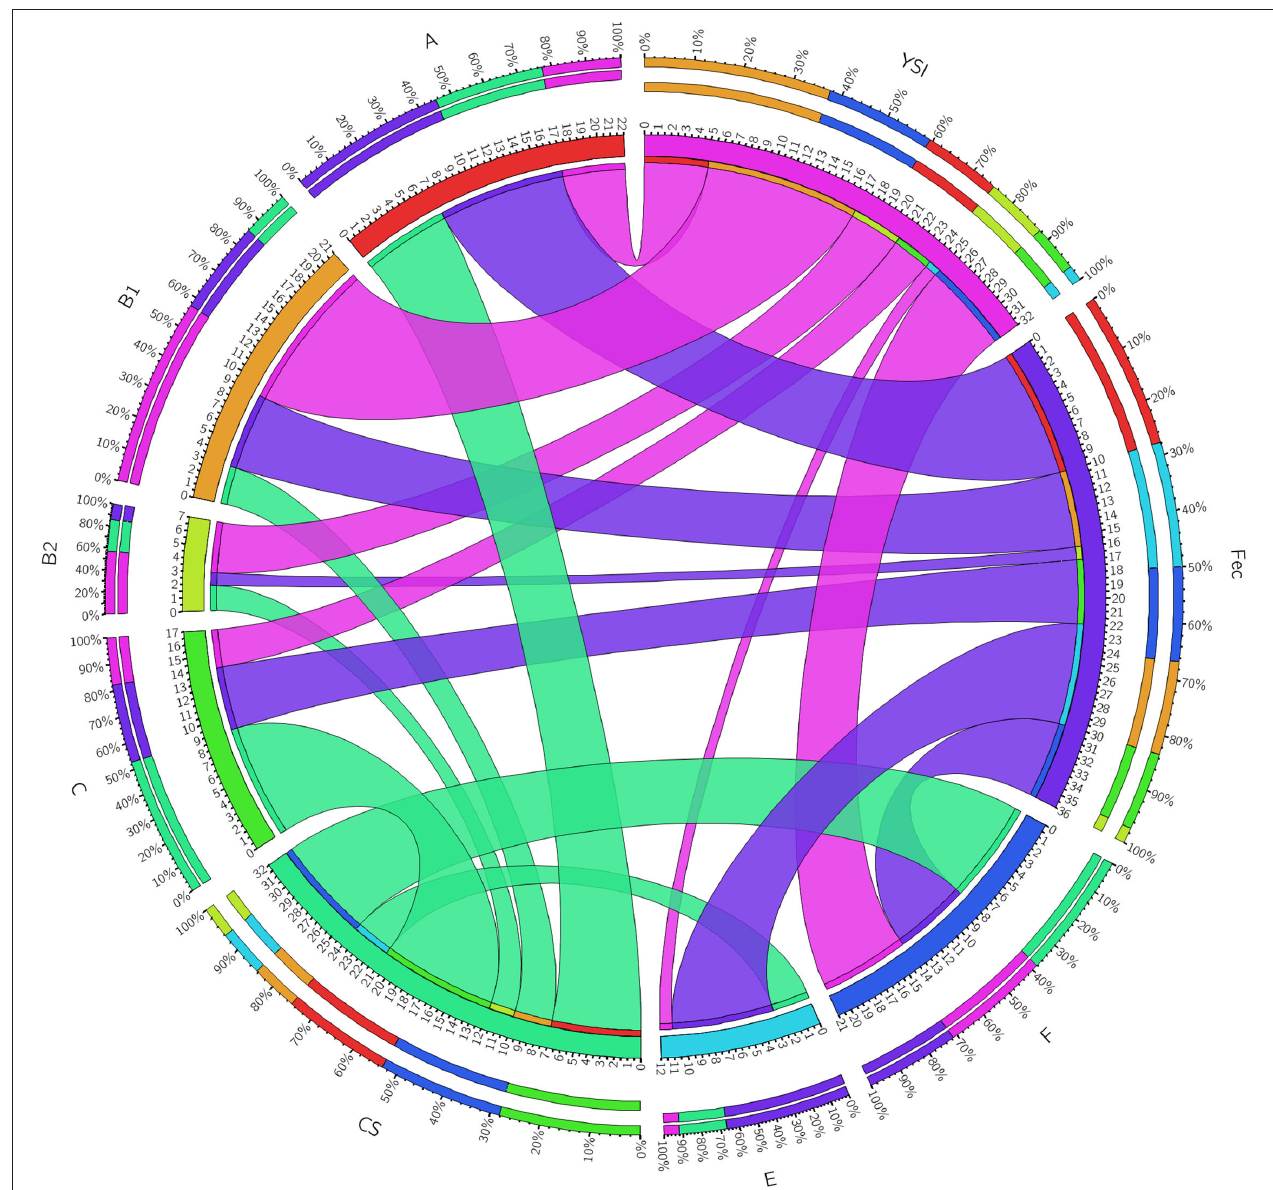
FIGURE 1 | A Circos plot presenting the distribution of Escherichia coli strain phylogroups in YSI, yolk sak infection; CS, colisepticemia; Fec, fecal origins. The inner ring represents the number of strains in each group. The outer circle depicts distribution percentage of the traits in each group. The arc originates from strain source and terminates at the phylogenetic group. The area of each colored ribbon depicts the frequency of the strains related to the origin and